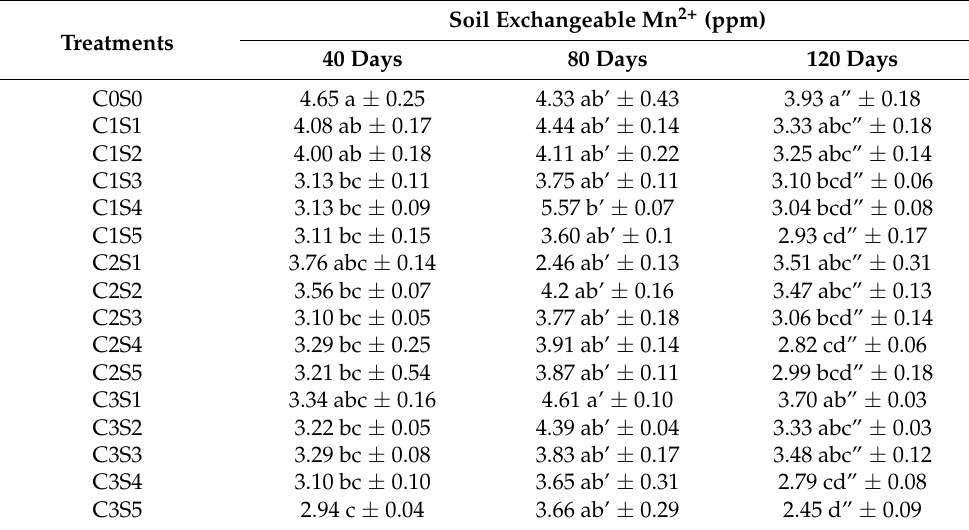
Table 7. Mean soil exchangeable manganese in relation to combined use of Calciprill and sodium silicate at forty, eighty, and one hundred and twenty days